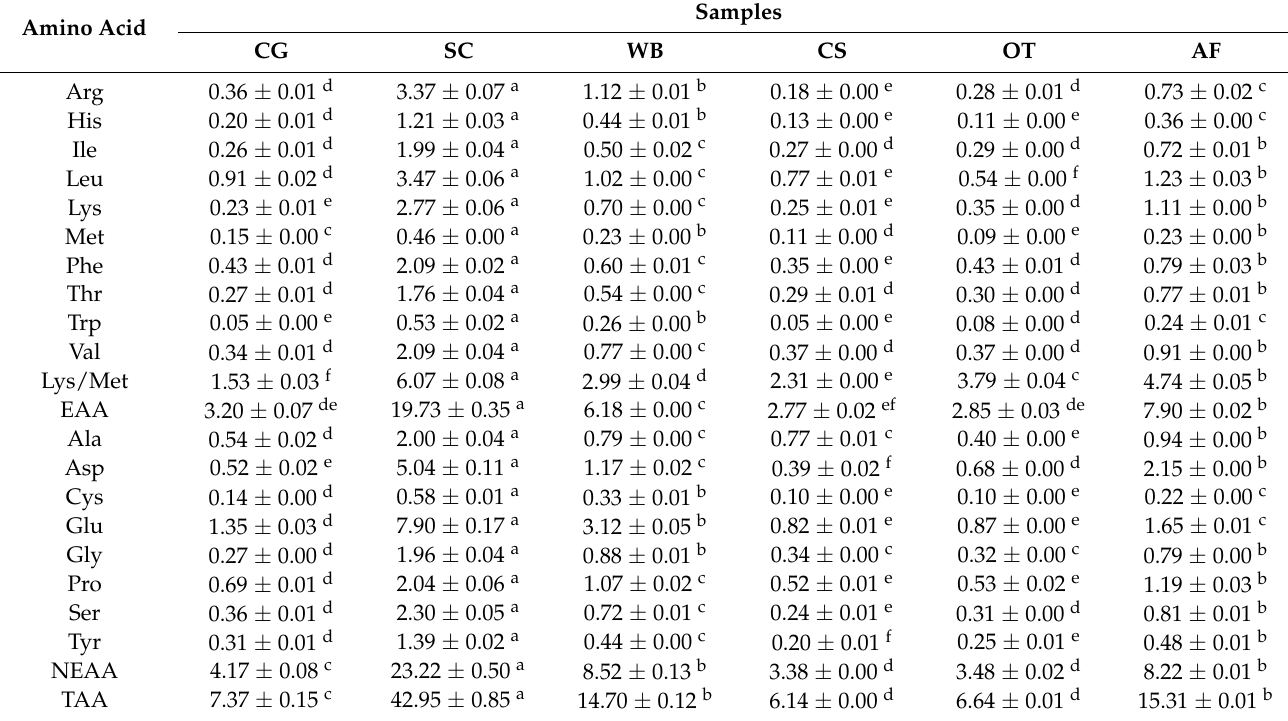
Table 3. Amino acid composition of six kinds of organic feed (%DM